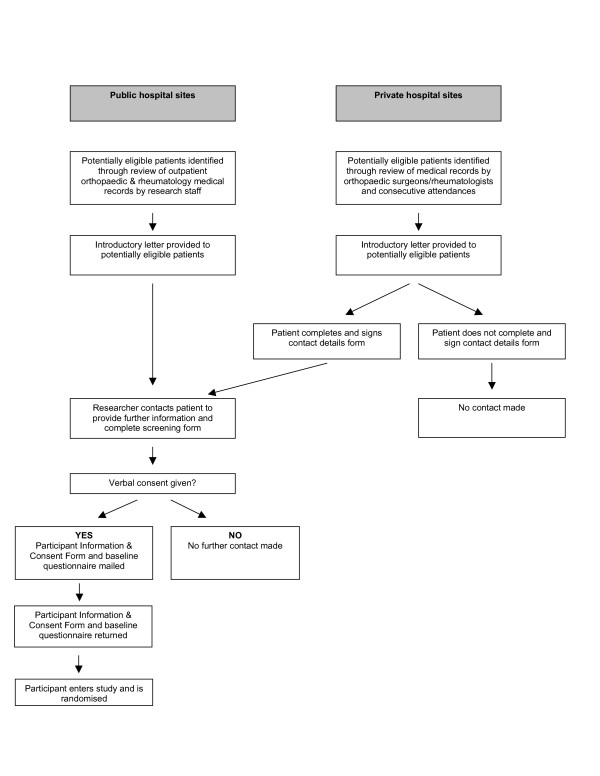
Identification and recruitment of study participants.